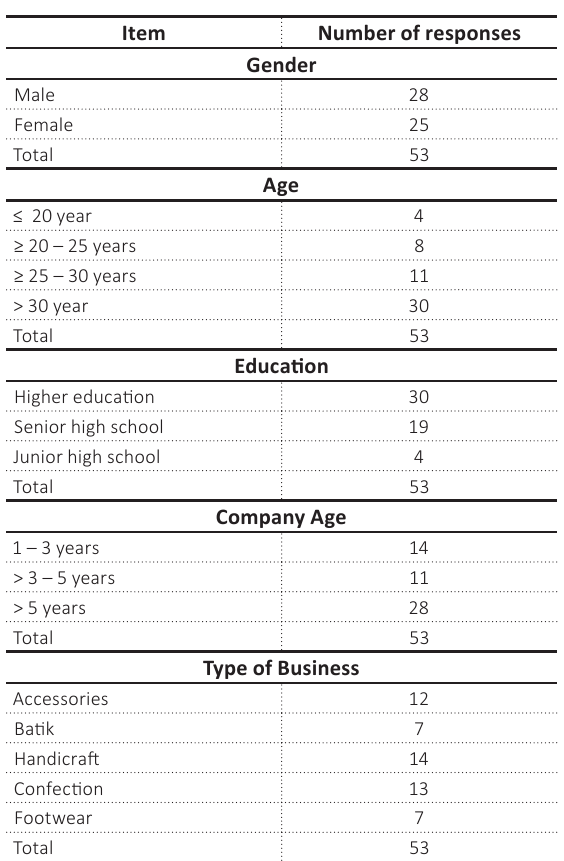
Table 1. Respondent